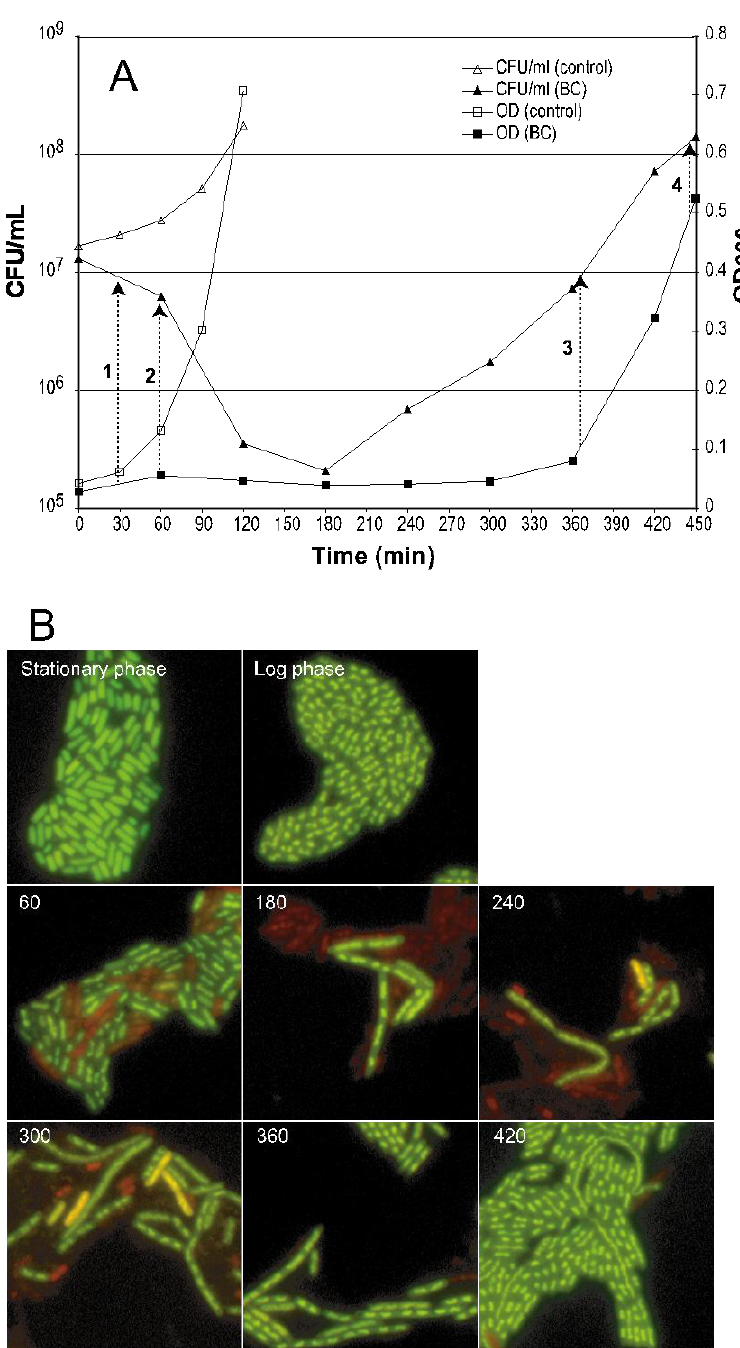
Figure 1. ( A ) Growth curves (CFU/mL and OD) and ( B ) Bac Light pictures of E. coli cells exposed to BC (9 µg/mL) and control at 0 (stationary phase), 60, 120, 180, 240, 300, 360 and 420 min after inoculation. Open symbols represent the control, closed symbols represent cultures with BC. The arrows and numbers 1, 2, 3 and 4 refer to the sampling points used for real-time PCR